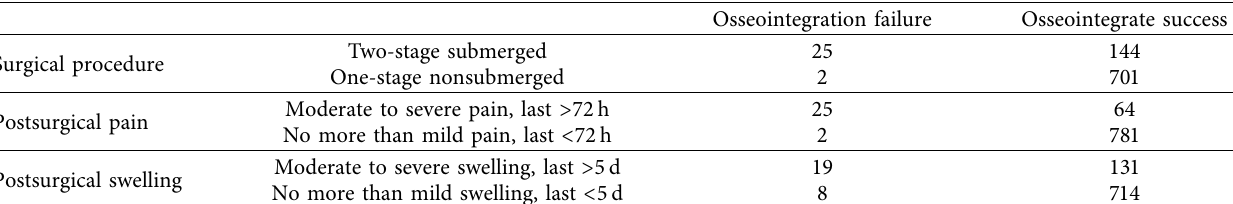
Figure 2: (a) Postsurgery pain score trend in two different groups. (b) Pain score distributions reported by the patients under different following-up time points in two groups ( ∗∗ p < 0 . 01, versus of group and control Table 2: Patient distribution with different relative factors.